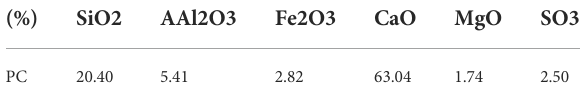
aggregate sizes of 4 mm and coarse aggregate sizes of 12 mm were utilized. The ratio of water to cement was selected as 0.60 while the ratio of cement to aggregate was selected